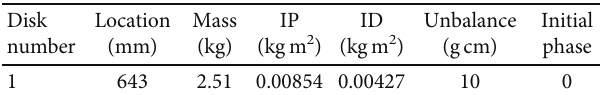
Table 3: Disk parameters.